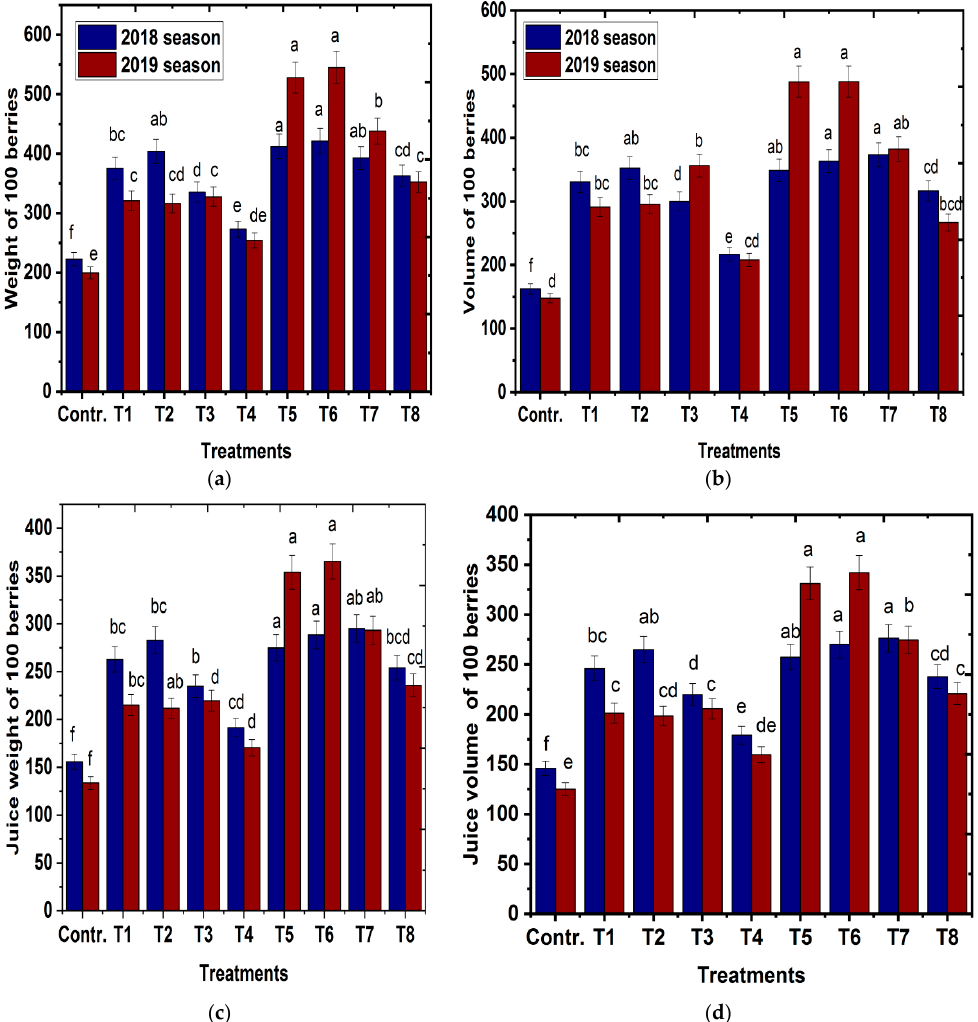
Figure 6. Effect of GA 3 sizing on ( a ) the weight of 100 berries, and ( b ) the volume of 100 berries, ( c ) juice weight of 100 berries, ( d ) juice volume of 100 berries of Sultanina grapevines (H4 strain) in 2018 and 2019. Contr. without removing any shoulders of the cluster, T1: 25% hand thinning + 20 ppm GA 3 sizing, T2: 25% hand thinning + 30 ppm GA 3 sizing, T3: 25% hand thinning + 40 ppm GA 3 sizing, T4: 25% hand thinning Without GA 3 sizing, T5: 50% hand thinning + 20 ppm GA 3 sizing, T6: 50% hand thinning + 30 ppm GA 3 sizing, T7: 50% hand thinning + 40 ppm GA3 sizing and T8: 50% hand thinning without GA 3 sizing. Means in each column followed by the same letter (s) are not significantly different at ( p ≤ 0.05), using Duncan’s Multiple Range